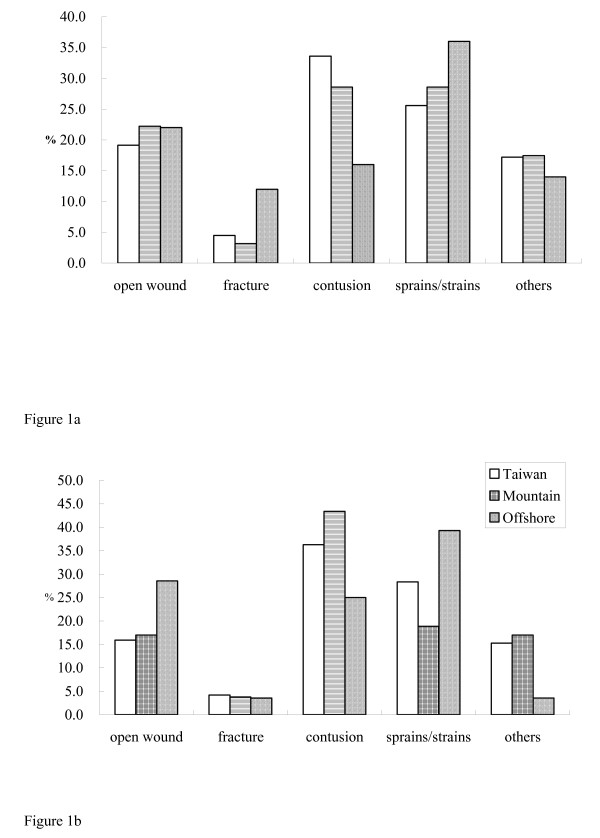
Figure 1a: Distribution of injury types in various regions for Taiwanese males. Figure 1b: Distribution of injury types in various regions for Taiwanese females